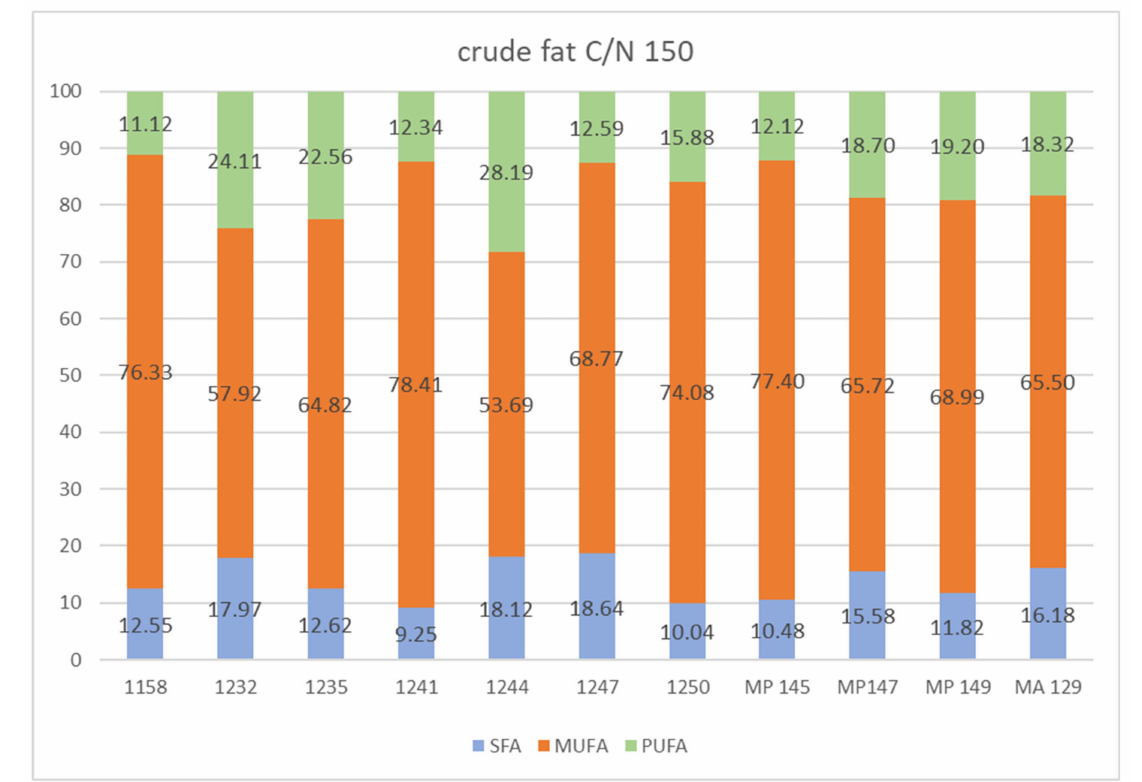
Figure 6. The percentage of saturated (SFA), monounsaturated (MUFA), and polyunsaturated (PUFA) fatty acids (FA) Legends: Metschnikowia chrysoperlae 1158 (MC 1158), Metschnikowia pulcherrima 1232 (MP 1232), Metschnikowia fructicola 1235 (MF 1235), Metschnikowia andauensis 1241 (MA 1241), Metschnikowia sinensis 1244 (MSi 1244), Metschnikowia zizyphicola 1247 (MZ 1247), Metschnikowia shanxiensis 1250 (MSh 1250), Metschnikowia pulcherrima 145 (MP145), Metschnikowia pulcherrima 147 (MP147), Metschnikowia pulcherrima 149 (MP149), Metschnikowia andauensis 129